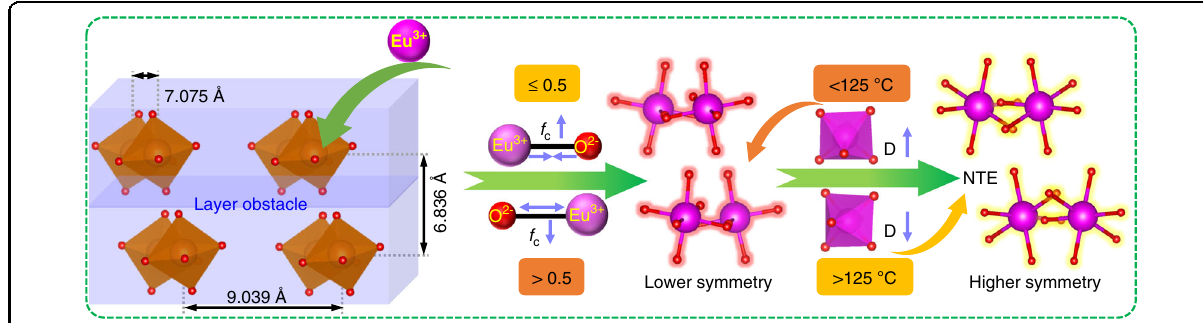
Fig. 6 Relationship between structural feature and photoluminescence properties. Schematic illustration of the effect of the crystal structure on the non-concentration quenching and temperature-dependent PL